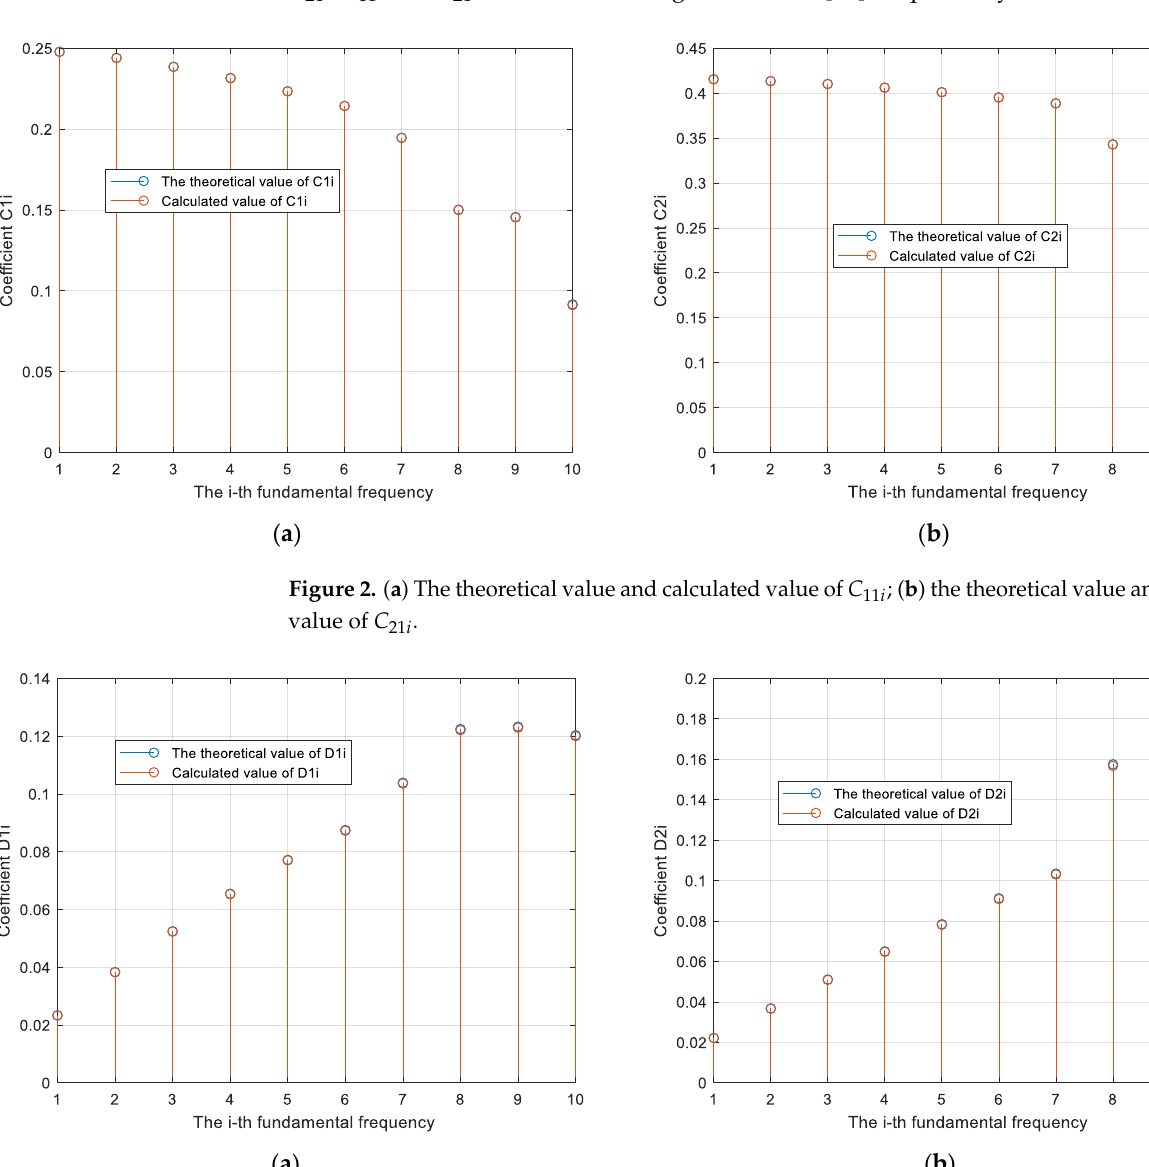
Figure 1. Input torque signal 𝜏